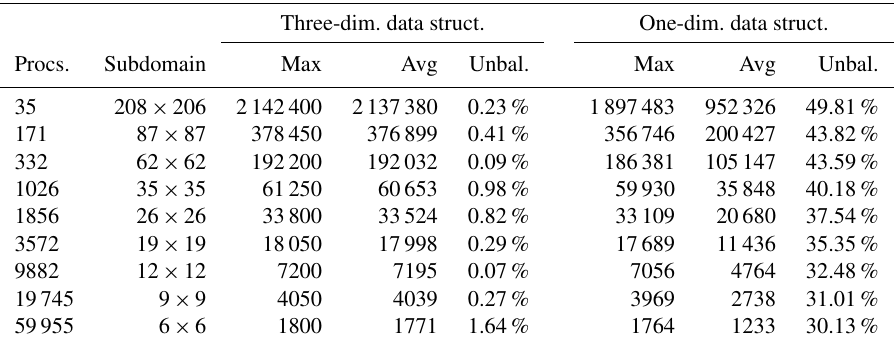
Table 6. Load balancing when adopting the three-dimensional or one-dimensional data structure. The first column reports the number of processes followed by the dimension of the biggest domain. The Max and Avg columns report the maximum number of grid points (i.e. the number of grid points for the biggest domain) and the average value among all the domains. The Unbal. columns give the estimation of the overhead due to unbalancing. It is computed as (Max − Avg) / Max. Three-dim. data struct. One-dim. data struct.